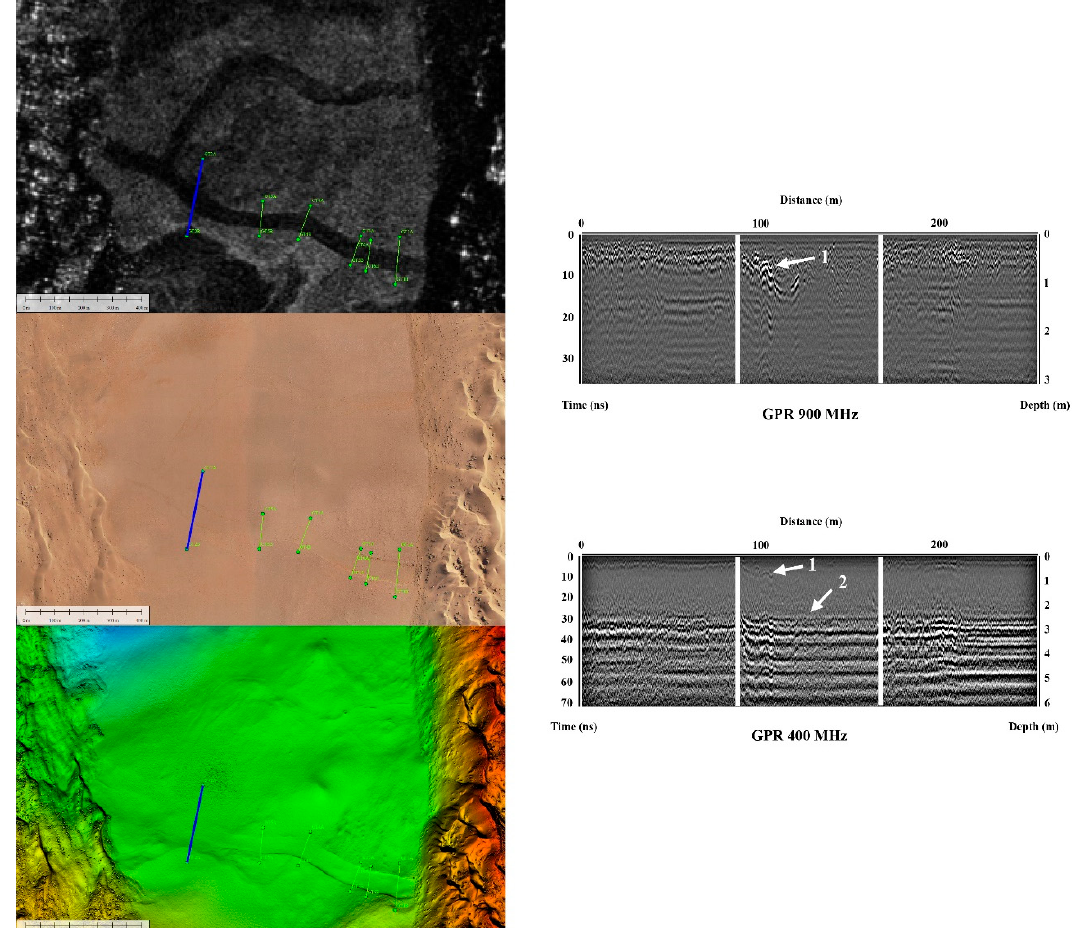
Figure 6. ( Left ): view of the Tsondab ID test site with GPR profiles GT1 to GT6 (PALSAR-2 top, drone-generated mosaic middle, drone-generated DEM bottom). ( Right ): GT2 ground-penetrating profile acquired at 900 MHz ( top ) and 400 MHz ( bottom ). Depth scale was computed using a dielectric constant ε = 3; the paleochannel is located between white lines. Two main horizons are indicated by white arrows 1 and 2.